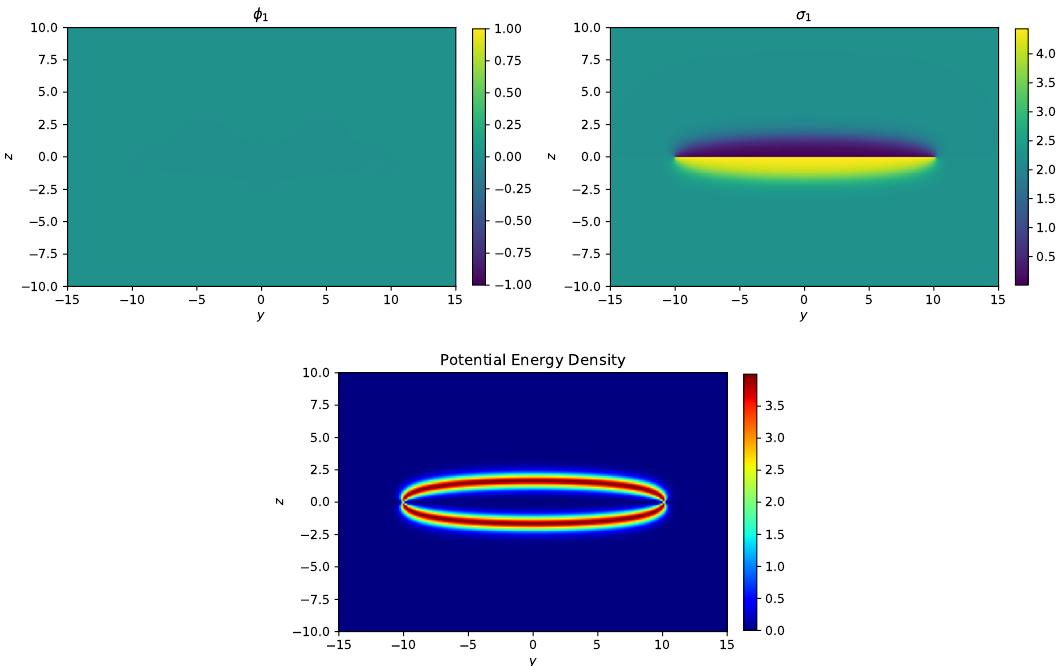
Figure 21. N = 4 double-string configuration with weight ν 1 , 3 . As a member of the p = 2 orbit, this configuration is confined by two BPS 2-walls, as expected from eq. (4.9). Note that these walls are “magnetless,” i.e., the φ field vanishes everywhere (see [28]). It is expected that, for a large enough separation, pair production of W -bosons will cause this double-string configuration to decay to the energetically more favorable one made of two BPS